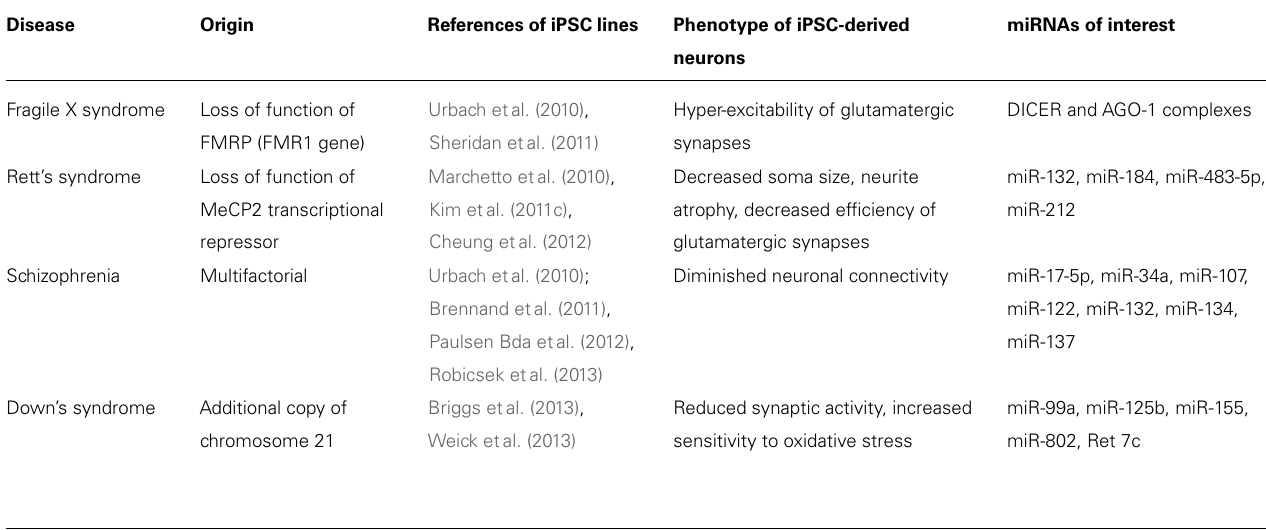
Table 1 | Summary of iPSC lines in which the role of miRNAs dysregulated in animal models or human brains can be further investigated.